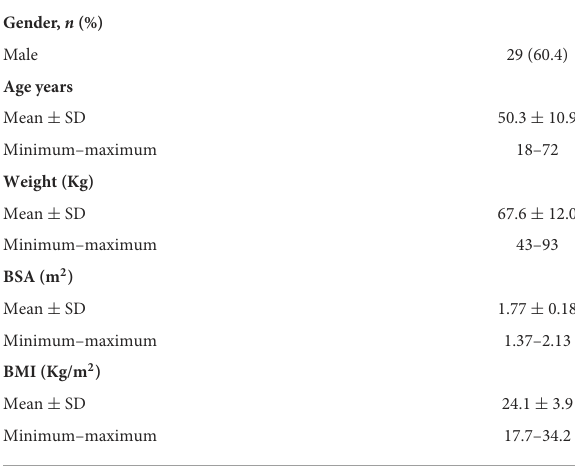
TABLE 1 Clinical and demographic characteristics of the 48 patients included in the